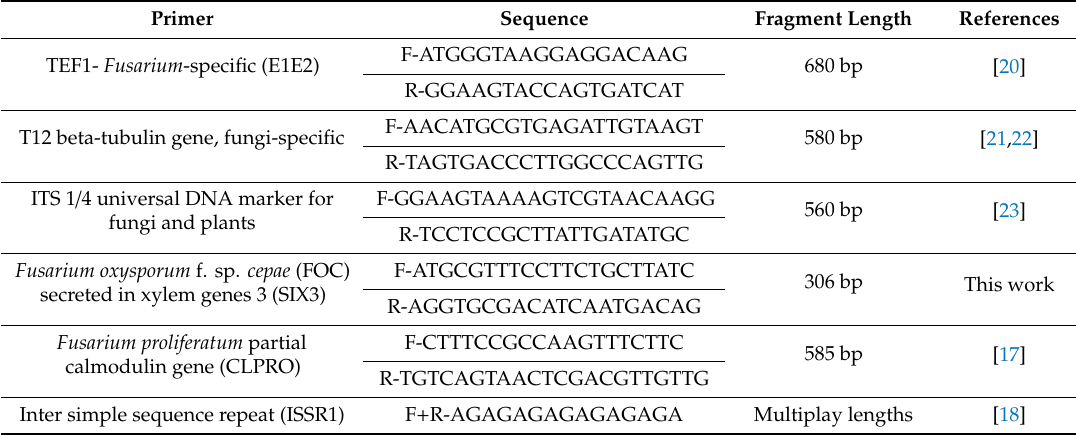
Table 1. Primers used in this study for Fusarium spp.